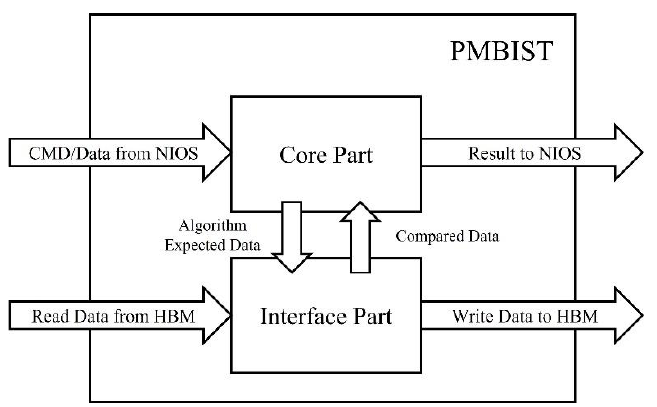
Figure 3. Two major sub-blocks in the PMBIST engine and their data and command flows.